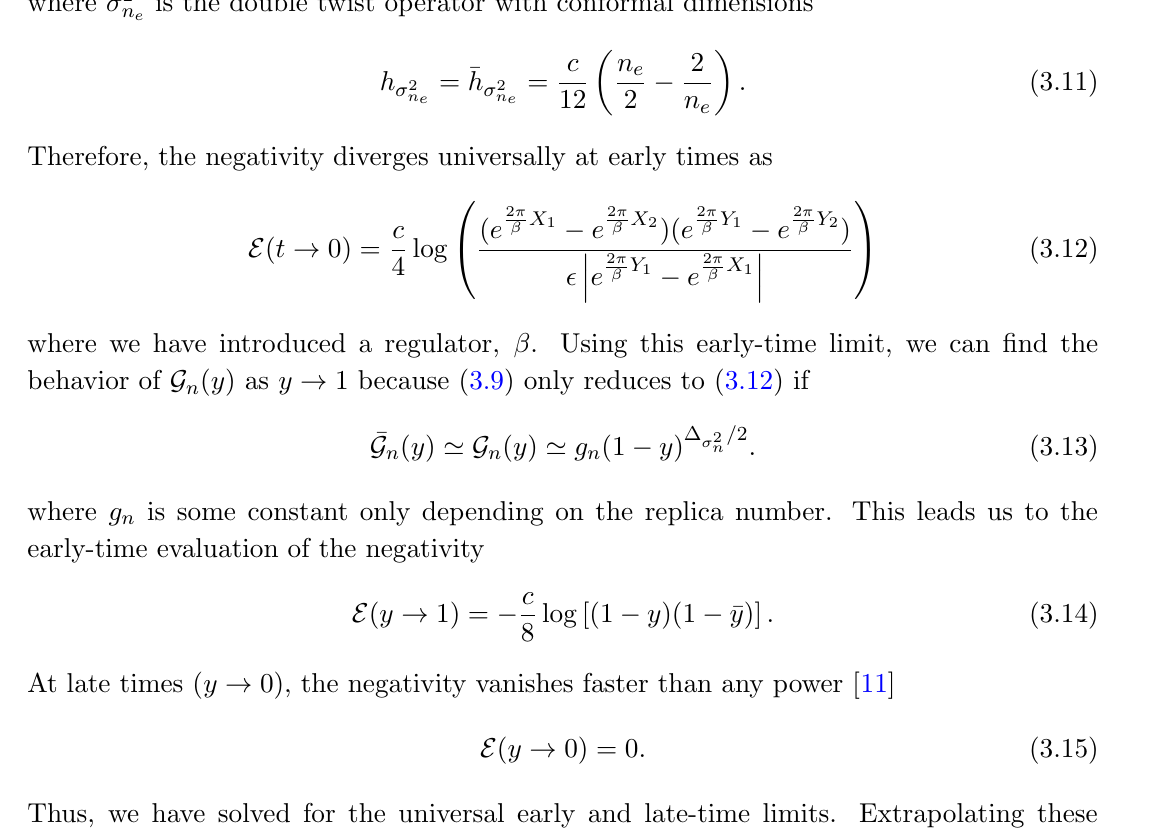
Figure 3 . We display the positions of the twist-(cid:12)elds used for the universal limit with the blue region corresponding to A 1 and the red A 2 . At very early times, we can take the (cid:27) n (cid:2) (cid:27) n = (cid:27) 2 OPE to obtain a 3-point function similar to the one for negativity of adjacent intervals [10]. where (cid:27) 2 is the double twist operator with conformal n e